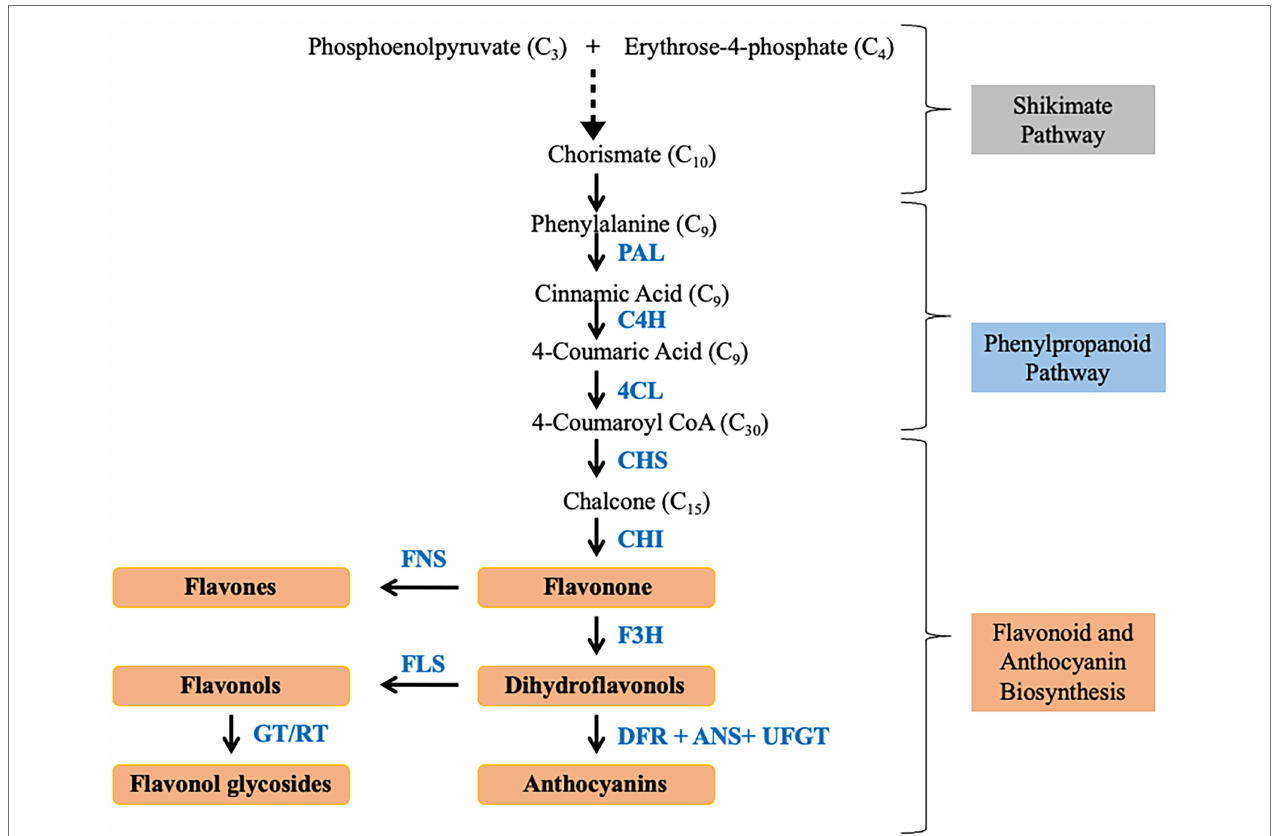
FIGURE 3 | Schematic flowchart depicting flavonoid and anthocyanin